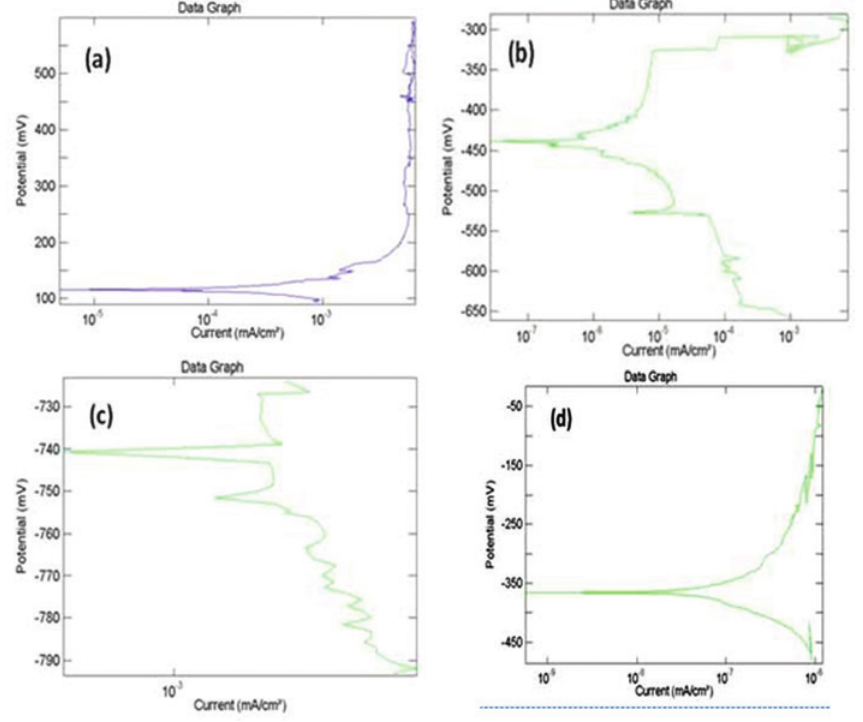
Figure 9: Polarization curve.